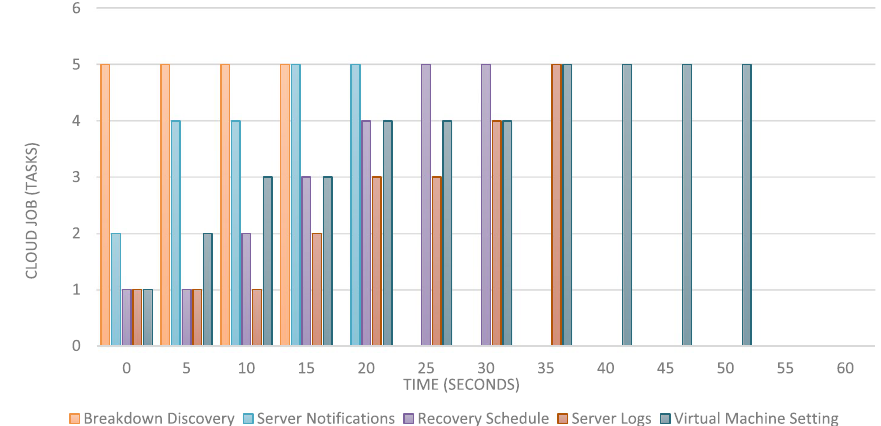
Fig. 19 The recovery process overheads of (Ad‑hoc Cloud System) through time in